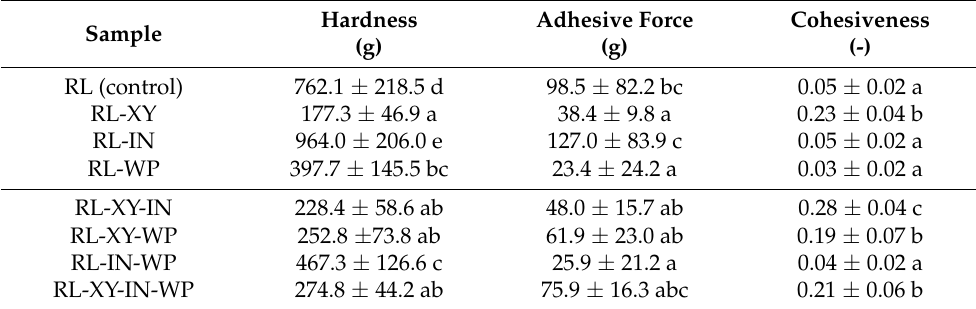
Table 7. Textural properties of red lentil